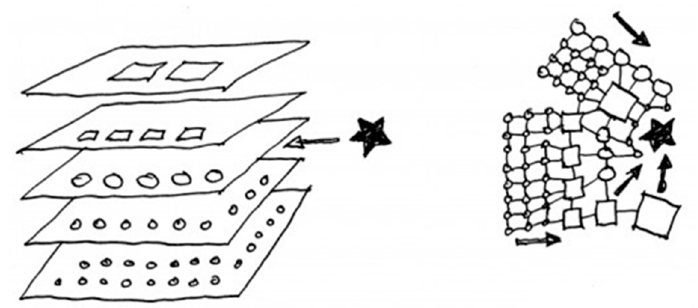
Figure 1. A complex resilient system coordinates its multi-scale response to a disturbance on any single scale [1].